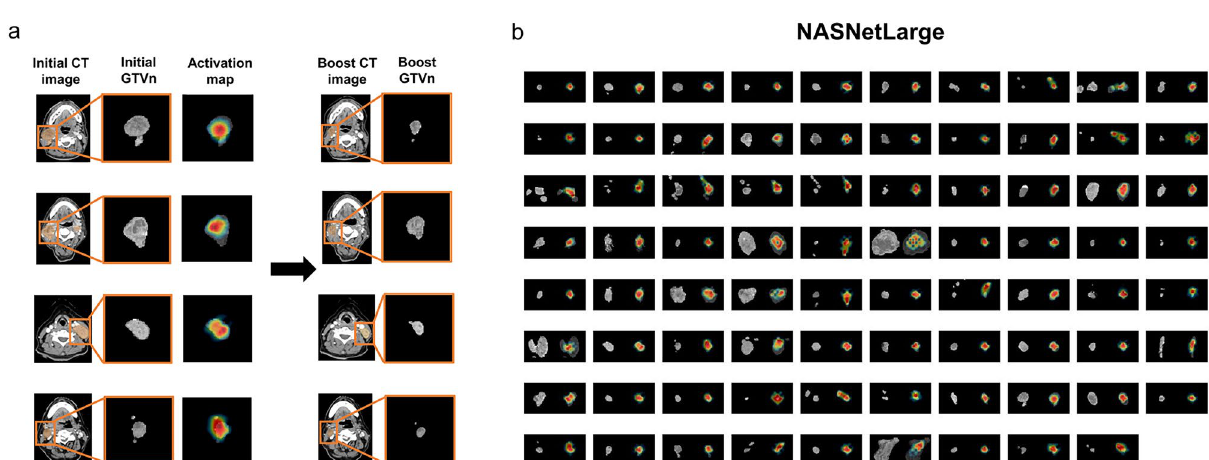
Figure 5. Activation maps of the initial CT images reveal salient features used by InceptionResNetv2-based models for prediction of GTVp regression. ( a ) Activation map of the initial CT image from patients with large GTVp regression using InceptionResNetv2 (the CNN yielding the highest predictive accuracy). The map was visualized using the Gradient Weighted Class Activation Mapping method. The boost CT images are shown to indicate the degree of regression. ( b ) Activation map of the initial GTVp images for all patients yielded by InceptionResNetv2.